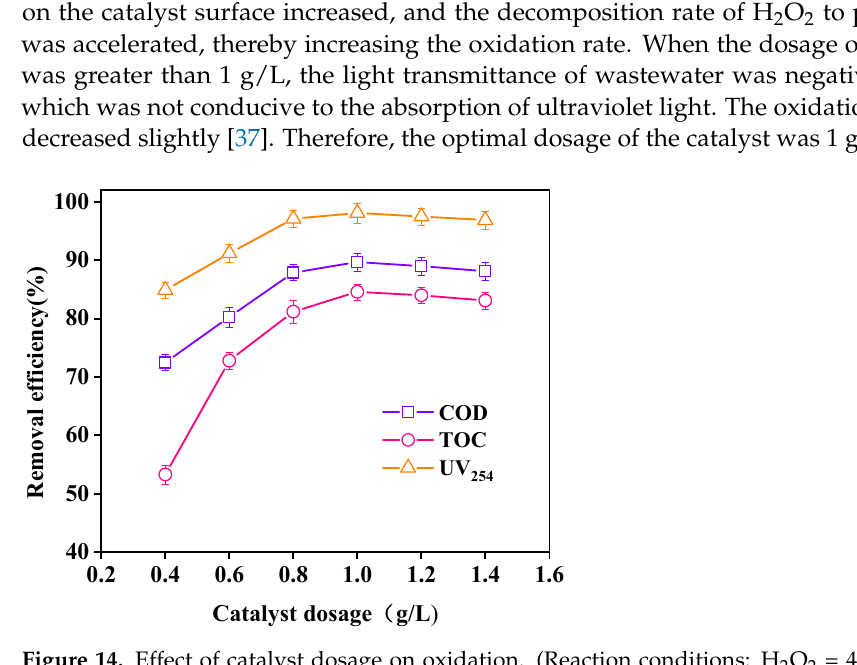
Figure 15. Effect of repeated use of catalyst on catalysis. (Reaction conditions: LaCoO 3 /CeO 2 = 1 g/L, H 2 O 2 = 40 mM, 120 °C, 0.5 MPa, 60 min).